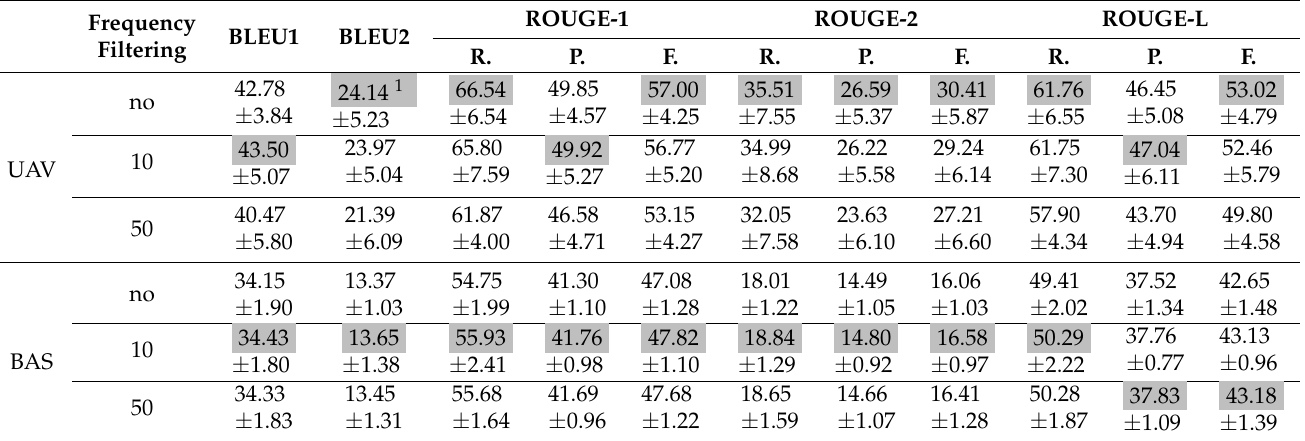
Table 4. The effectiveness of knowledge frequency filtering (%).